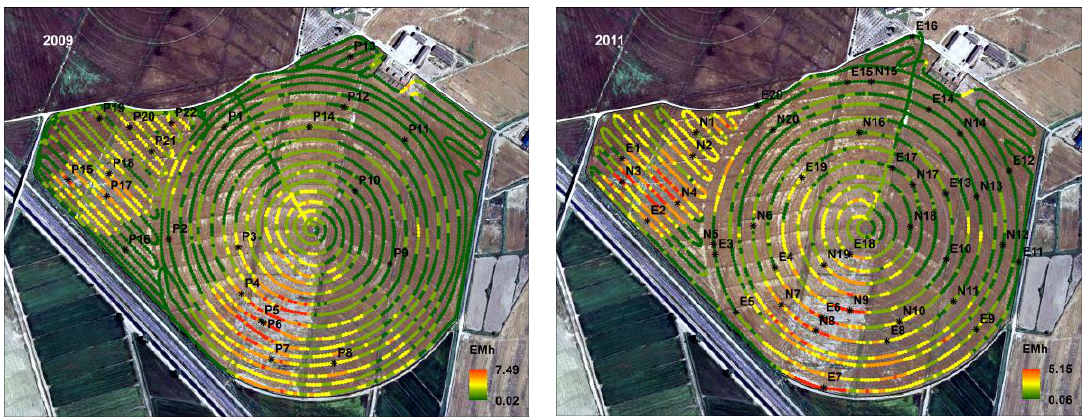
Figure 3. Location of the EMh readings and the soil sampling sites (black dots). Table 1. Total number of sites of EMI readings, sites by ha, and % inverted profiles (EMv < EMh); number of soil sampling sites, depth, sampling depth interval, and number of samples.